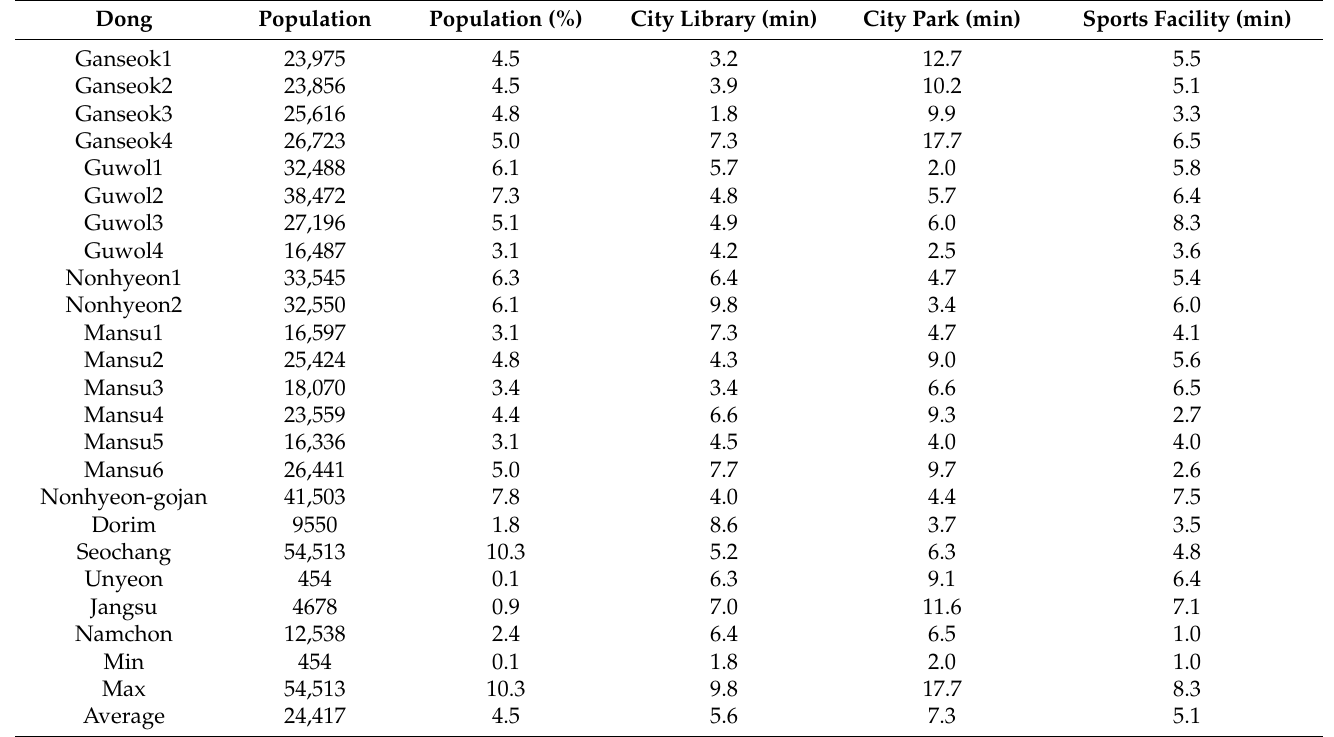
Table 4. AI by dong—vehicle